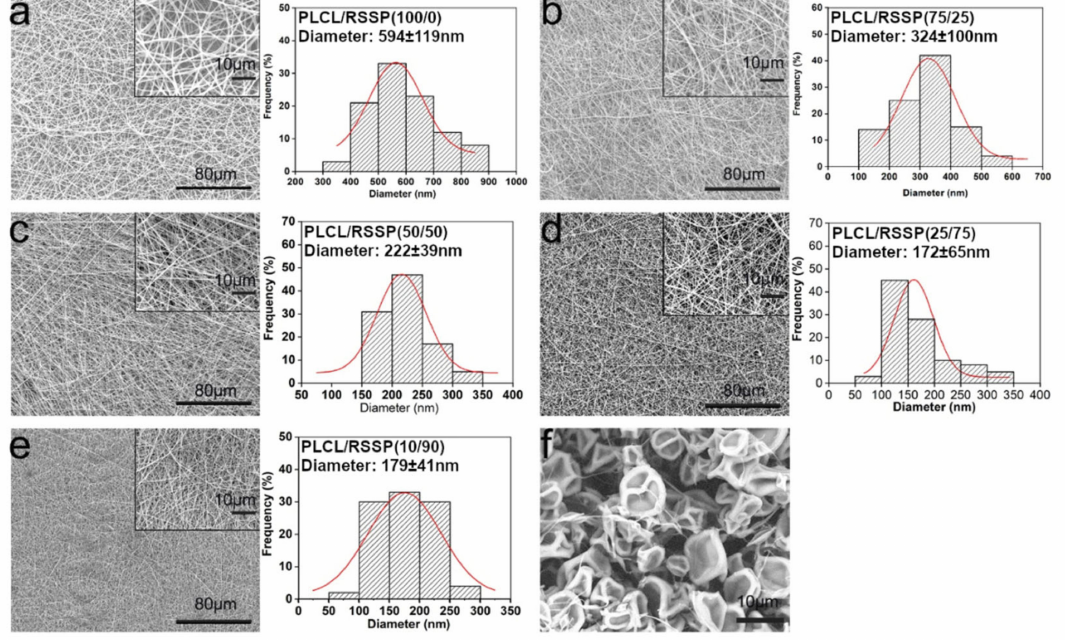
Figure 1. SEM images and diameter distribution histograms of nanofibrous membranes. ( a ) PLCL/ RSSP (100/0), ( b ) PLCL/RSSP (75/25), ( c ) PLCL/RSSP (50/50), ( d ) PLCL/RSSP (25/75), ( e ) PLCL/ RSSP (10/90) ( f ) PLCL/RSSP